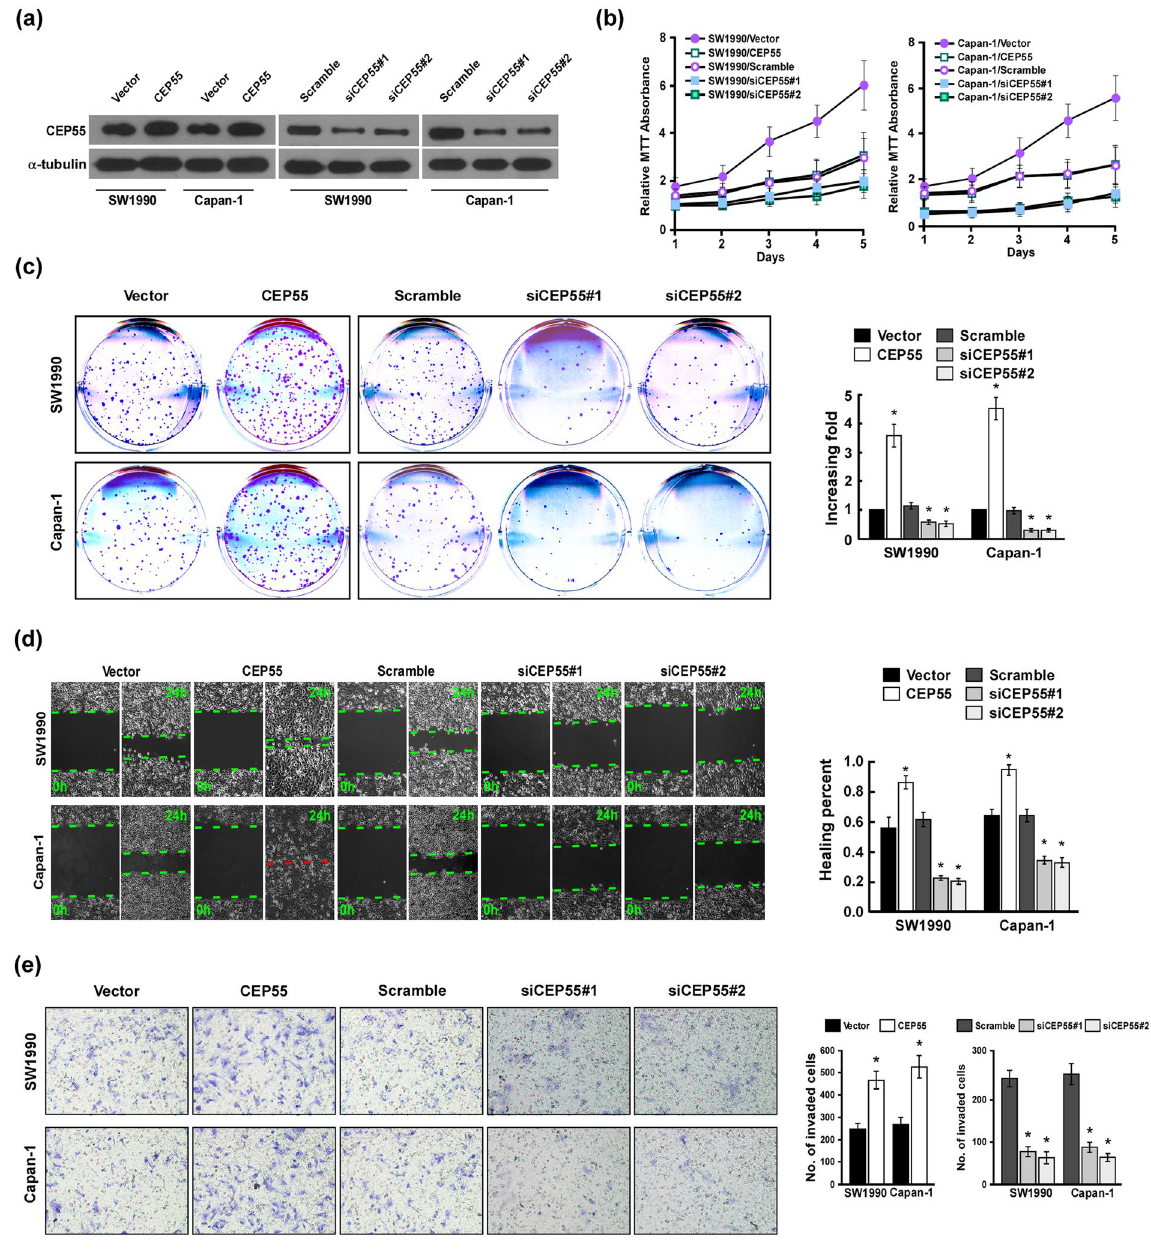
Figure 3. CEP55 overexpression promoted pancreatic cancer (PANC) cells aggressiveness in vitro . ( a ) Expression of CEP55 protein as detected by Western blot analysis in SW1990 and Capan-1 cells upon transfection with CEP55 or CPE55 short interfering RNAs (siRNAs). GAPDH was used as the loading control. ( b ) MTT (3-(4,5-Dimethylthiazol-2-Yl)-2,5-Diphenyltetrazolium Bromide) assay of SW1990 and Capan-1 cell growth curves following CEP55 or CEP55 siRNAs transfection. ( c ) Representative micrographs (left panel) and quantification (right panel) of crystal violet-stained SW1990 and Capan-1 cell colonies after 14 day of colony formation. ( d ) Wound-healing assay (left panel) and quantification (right panel) of the wound distance to assess SW1990 and Capan-1 cell migration after transfection with CEP55 or CEP55 siRNAs. ( e ) Representative micrographs (left panel) and quantification of SW1990 and Capan-1 cell invasion in a Transwell matrix penetration assay. The quantification of the invaded cells is represented by the mean of three independent experiments. Bars represent the mean ± SD of three independent experiments. * P <